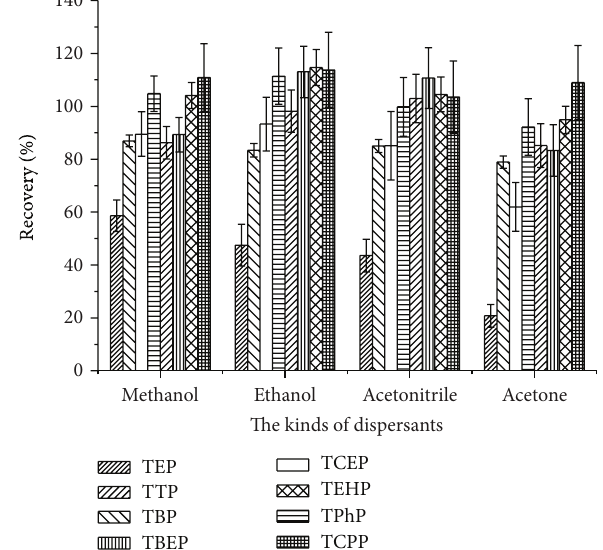
Figure 5: Optimization of